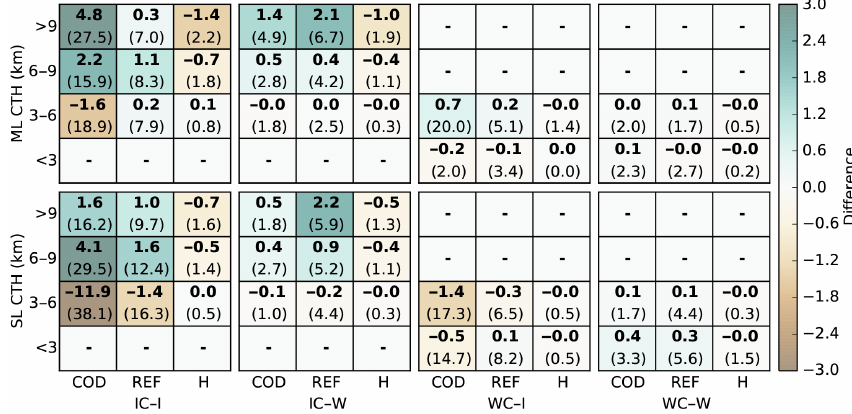
Figure 9. Mean microphysical differences between the ORAC and ORAC + stereo retrievals for various cloud and surface combinations where the ORAC and ORAC + stereo phases agree (the cloud height bins are defined by CALIOP, the surface bins by AMSR-E sea-ice product). See macrophysical table in Fig. 3 for codes to interpret